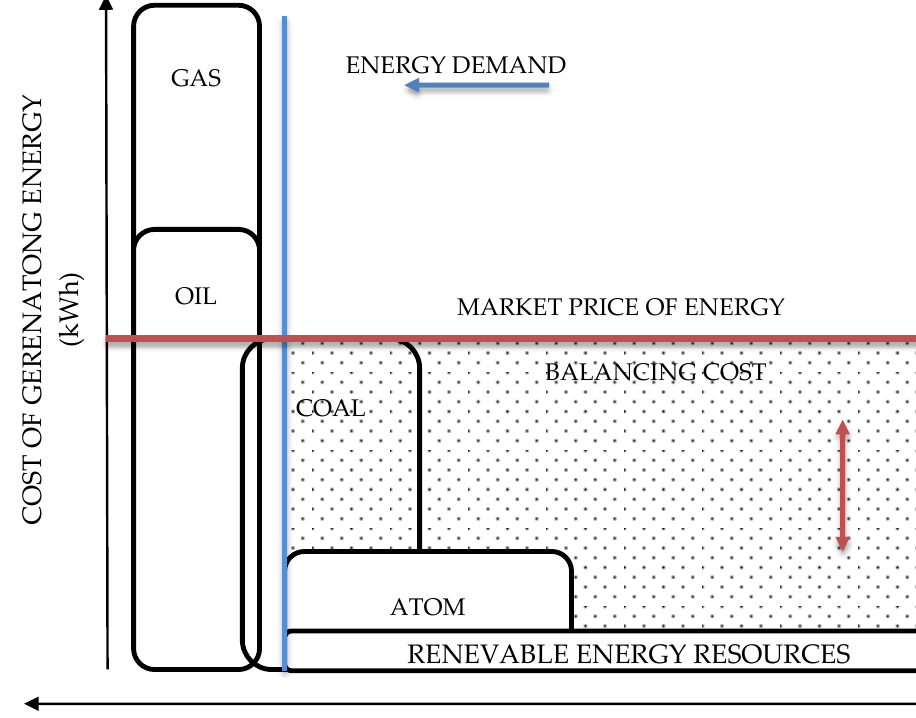
Figure 4. Electricity price structure